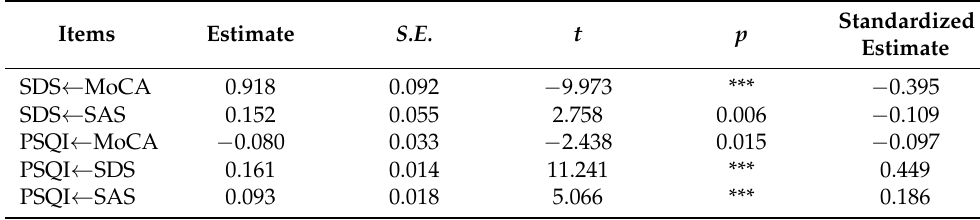
Figure 3. Mediating effects of depression (SDS score) on the relationship between cognitive function (MoCA score) and sleep quality (PSQI score) and on the relationship between anxiety (SAS score) and sleep quality (PSQI score). Table 3. Direct effects of variables.